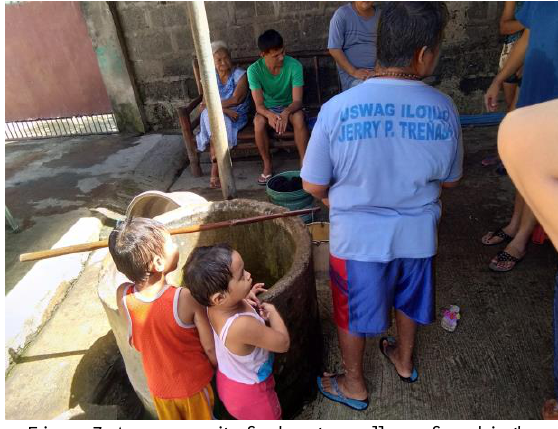
Figure 7. A community freshwater well was found in the vicinity of an old natural pond.